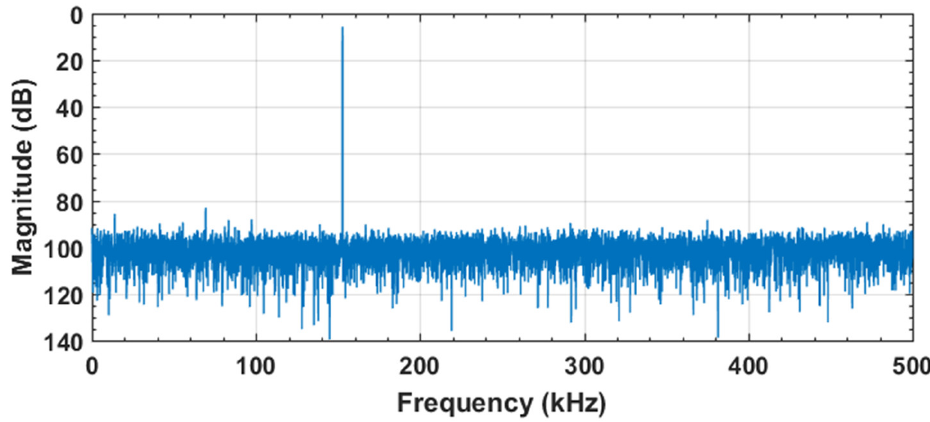
Figure 4. Dynamic performance of proposed switching with 1% unit capacitor mismatch.